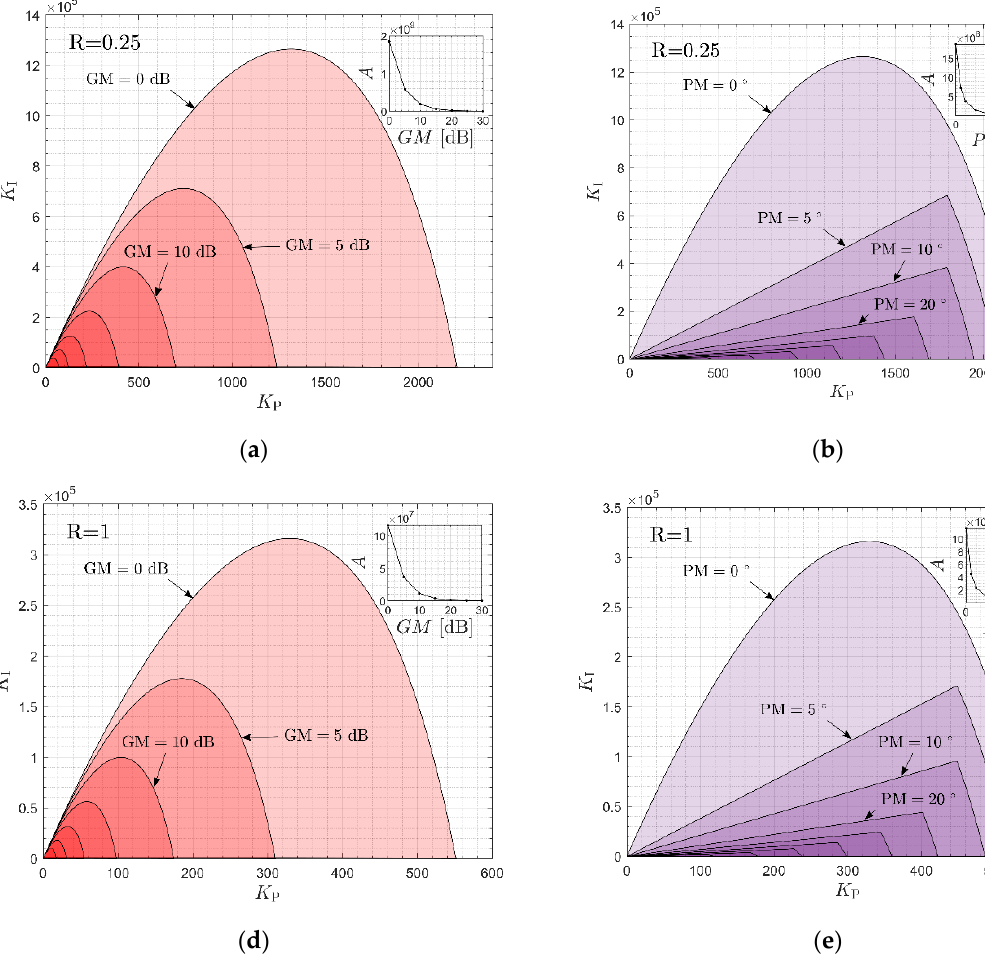
Figure 5. Visualisation of the desired regions for di ff erent value of the gain margin, GM , ( a , d ), phase margin, PM , ( b , e ) as well as selected value of GM = 20 dB and PM = 70 ◦ ( c , f ) for the control structure from Figure 2 and value of inertia ratio R = 0.25 ( a – c ) and R = 1 ( d – f ) calculated using D-decomposition technique. Results = 0.1 ms and τ = 0.5 ms. Additionally, the total area, A , of obtained regions were were obtained for T m A2D e